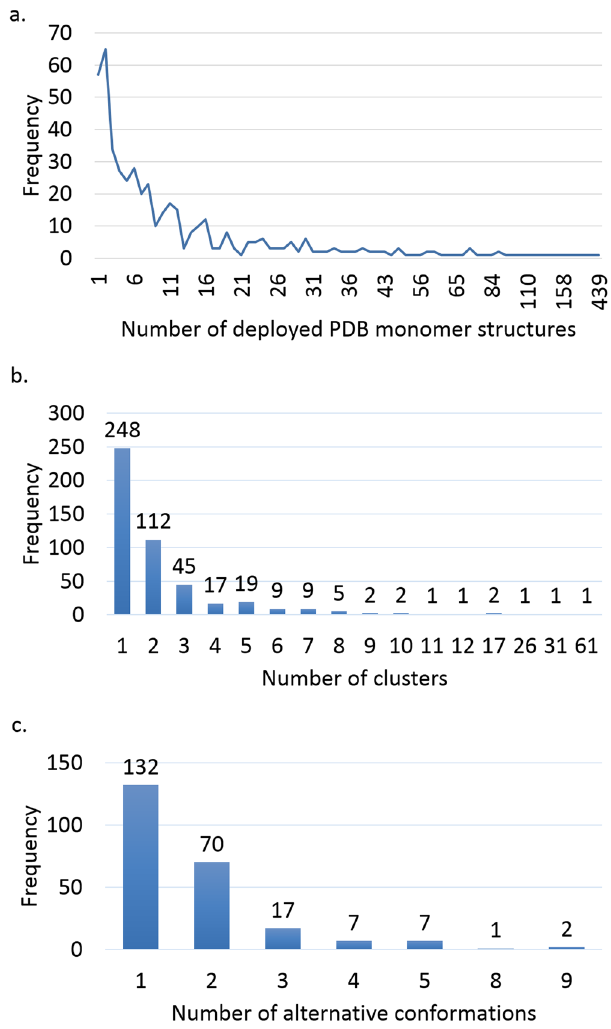
Figure 5. PDB database and clustering statistics. ( a ) Number of deployed monomer structures for each protein in the PDB database. ( b ) Number of different clusters for each protein based on our clustering algorithm. These clusters may represent different parts of the same protein or alternative conformations of it. ( c ) Number of the alternative conformations each protein has in our